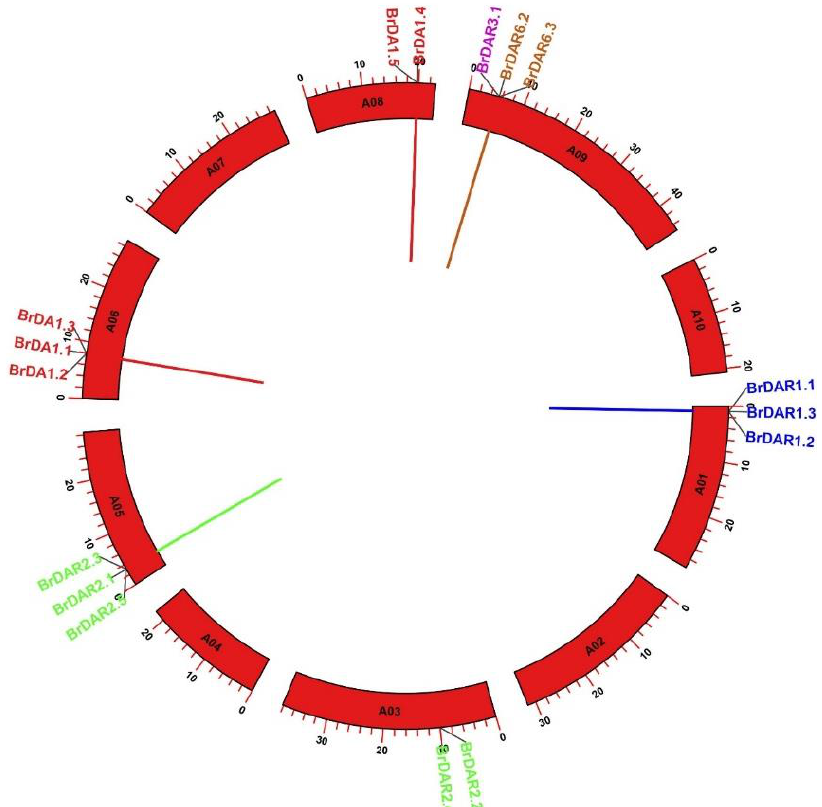
Figure 2. Circular representation of chromosomal distribution and interaction of BrDA1 & DARs evolved through tandem duplication. Based on phylogenetic analysis, different colors represent the presence of BrDA1 & DAR genes in different groups.